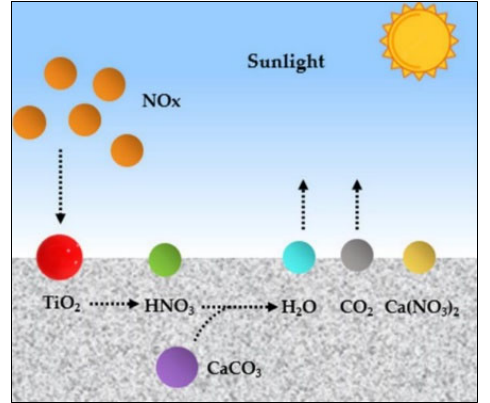
Fig. 4. Photo-oxidation process of a photocatalytic concrete Note. The graph represents the photooxidation process against contact with the sun and what are the components that are released into the air. Taken